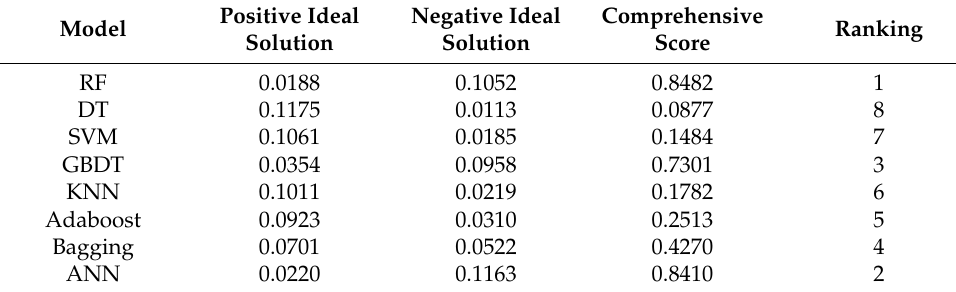
Table 5. Ranking results based on critic-TOPSIS